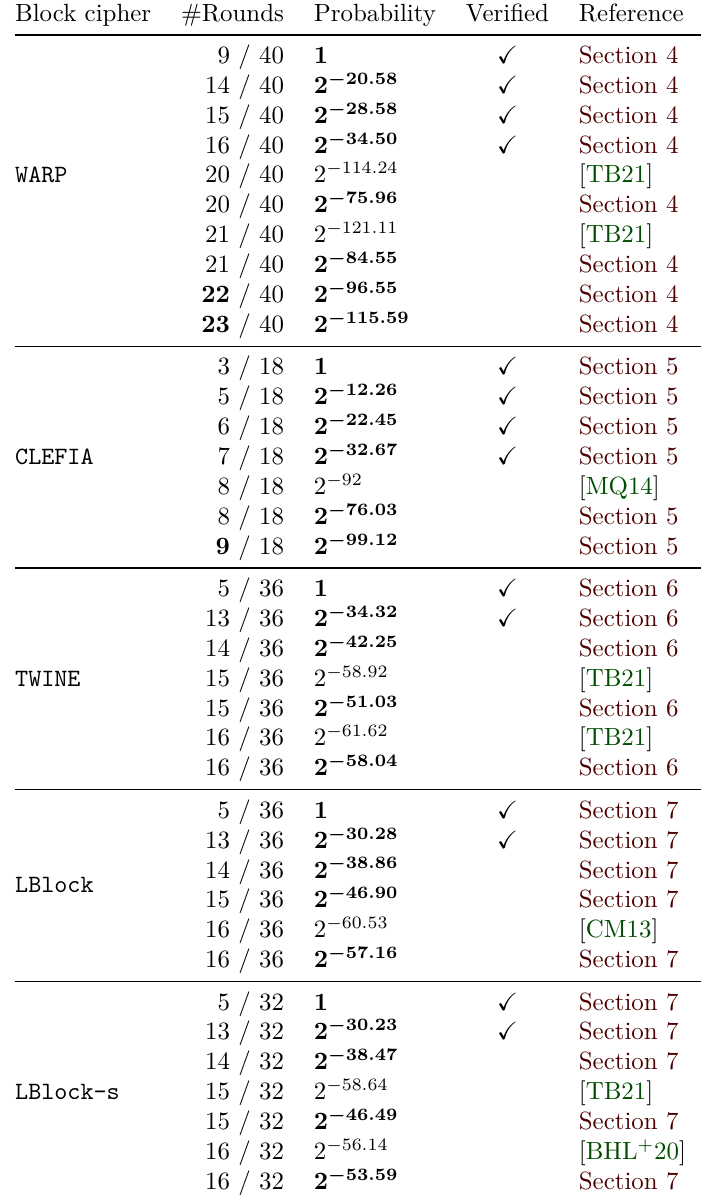
Table 1: Summary of boomerang distinguishers for WARP , CLEFIA , TWINE , and LBlock